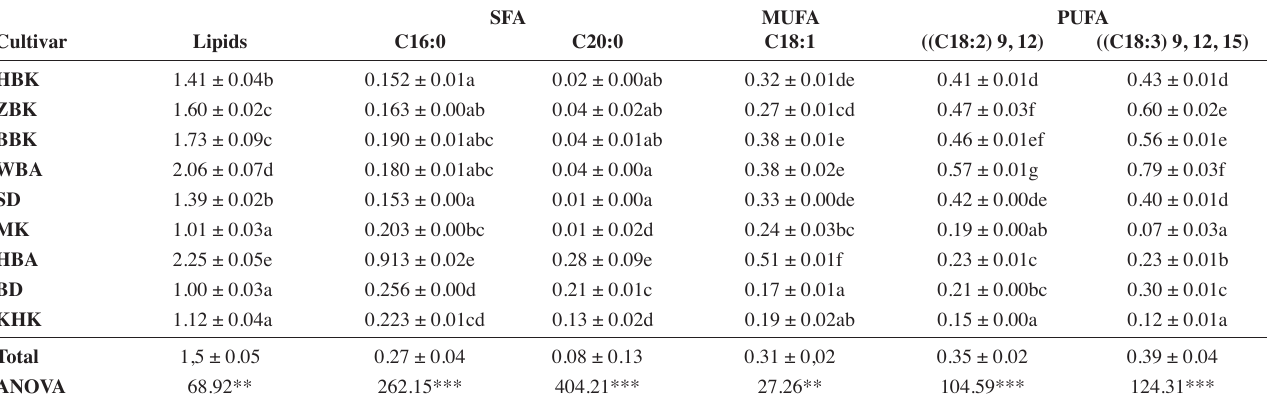
Tab. 4: Fatty acid contents and composition (g/100g DM) of studied dry fig